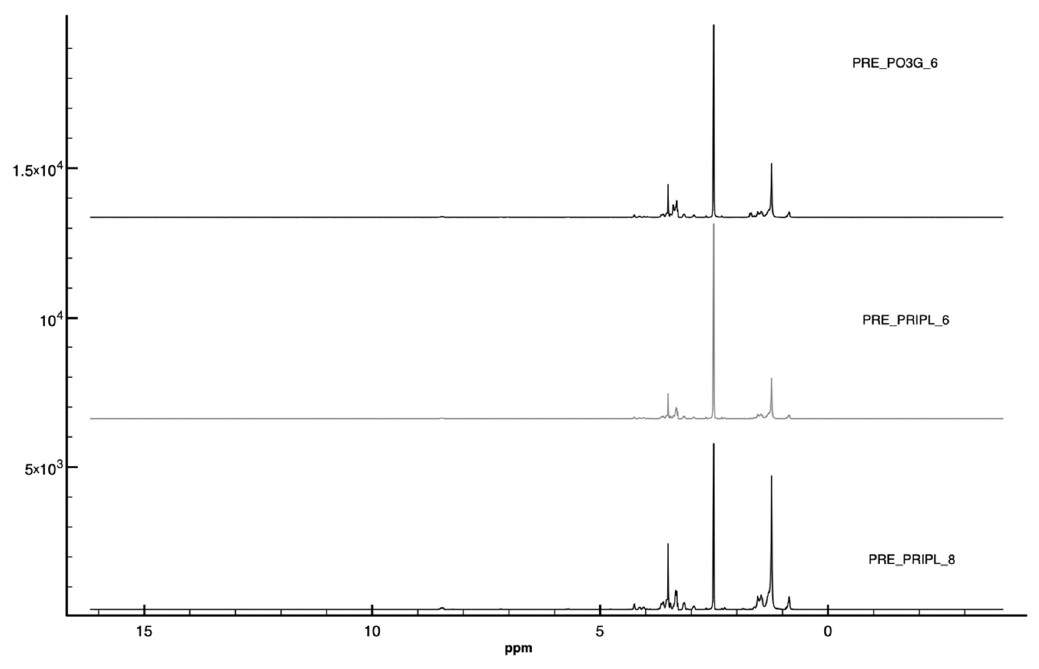
Figure 4. 1 H NMR spectra of PRE_PRIPL_6, PRE_PRIPL_8 and PRE_PO3G_6